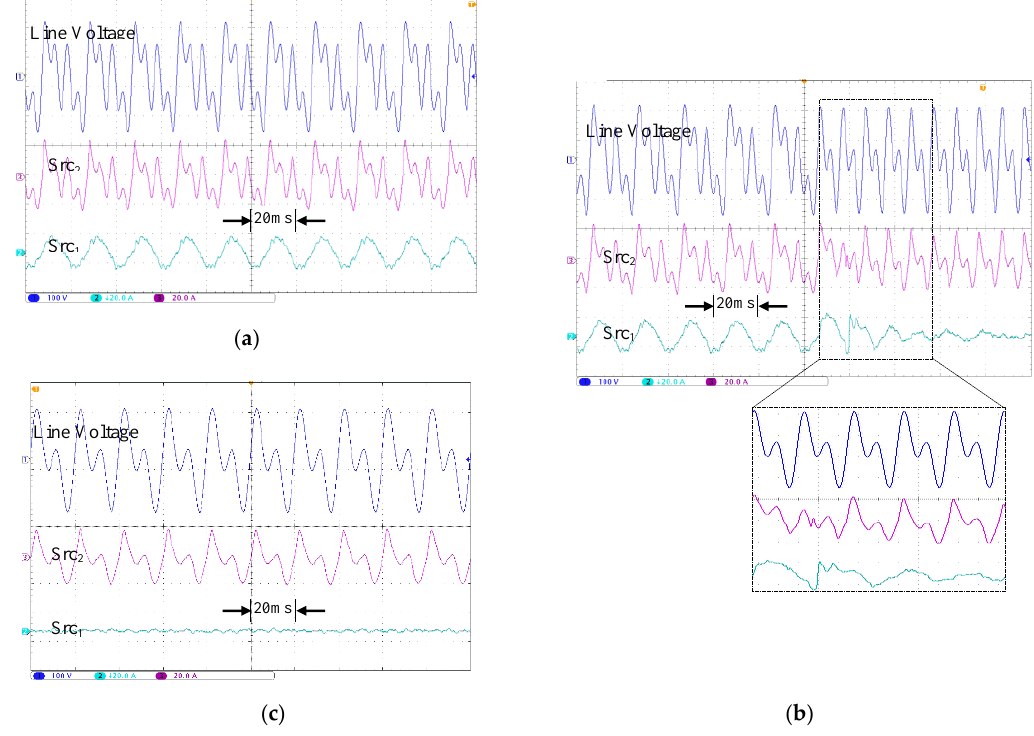
Figure 9. Experimental study sources’ behavior in multi-channel power system after grid disconnection